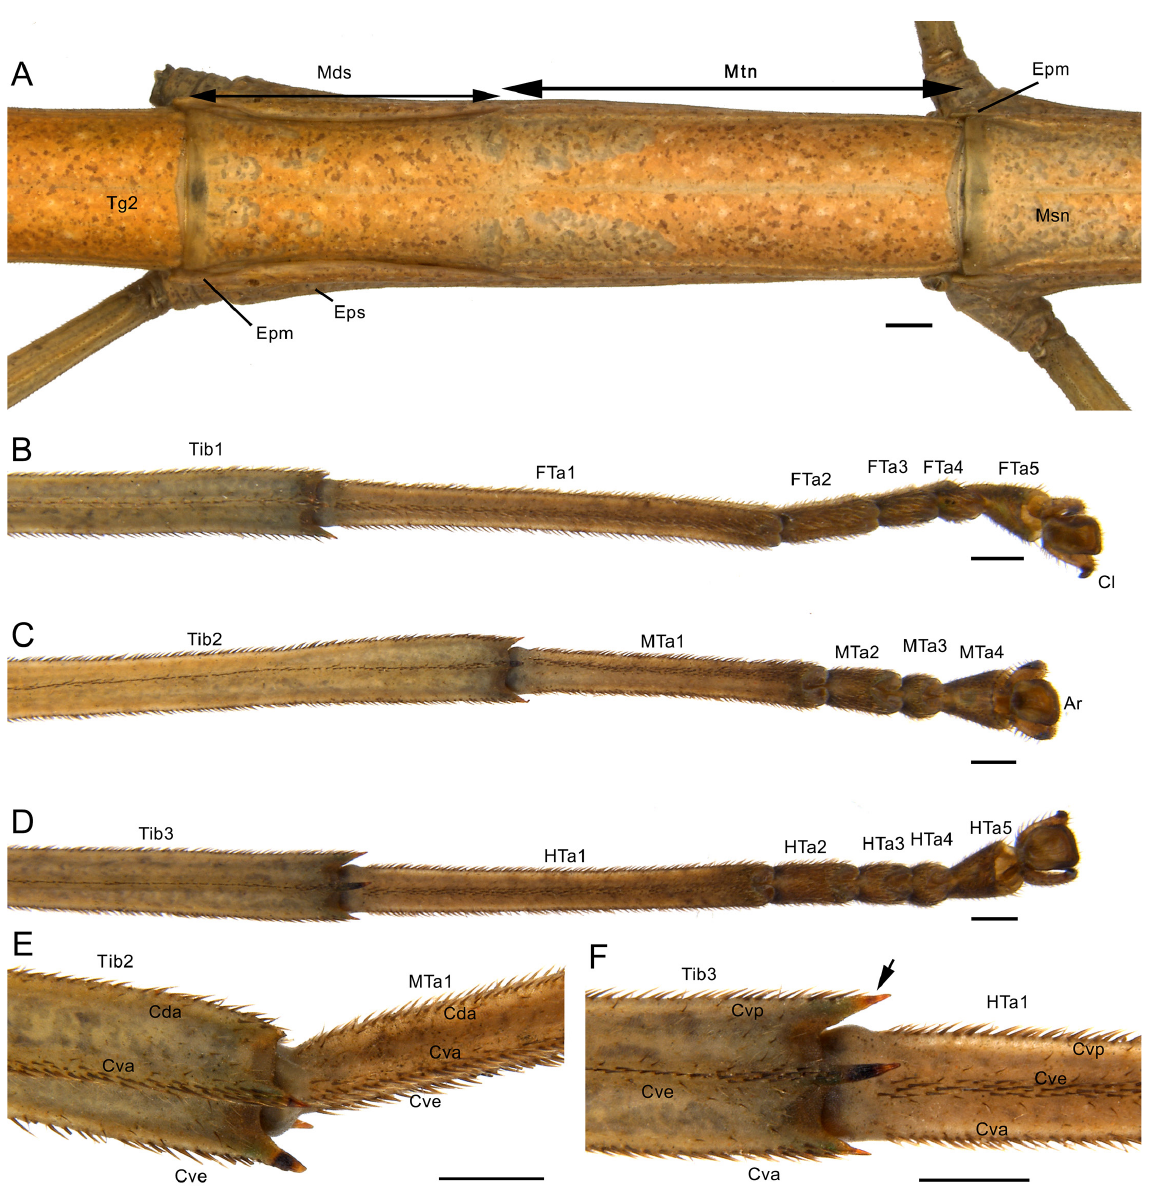
Fig. 36. Arumatia motenata Ghirotto gen. et sp. nov., holotype, ♀ (MZUSP V0603), thorax and leg morphology. A . Metathorax and median segment in dorsal view, arrows indicate the length of each segment. B . Left fore tarsus, ventro-prolateral view. C . Left mid tarsus, ventral view. D . Right hind tarsus, ventral view. E . Detail of right mid tibia and tarsus (mirrored), prolateral view. F . Detail of right hind tibia and tarsus, ventral view, arrow showing apical sessile spine. Abbreviations: Ar = arolium; Cda = dorsal anterior carina; Cl = claw; Cva = ventral anterior carina; Cve = ventral carina; Cvp; ventral posterior carina; Epm = epimeron; Eps = episternum; FTa = fore tarsomere; HTa = hind tarsomere; Mds = median segment; Msn = mesonotum; MTa = mid tarsomere; Mtn = metanotum; Tg = tergum; Tib = tibia. Scale bars: A = 1 mm; B–F = 0.5